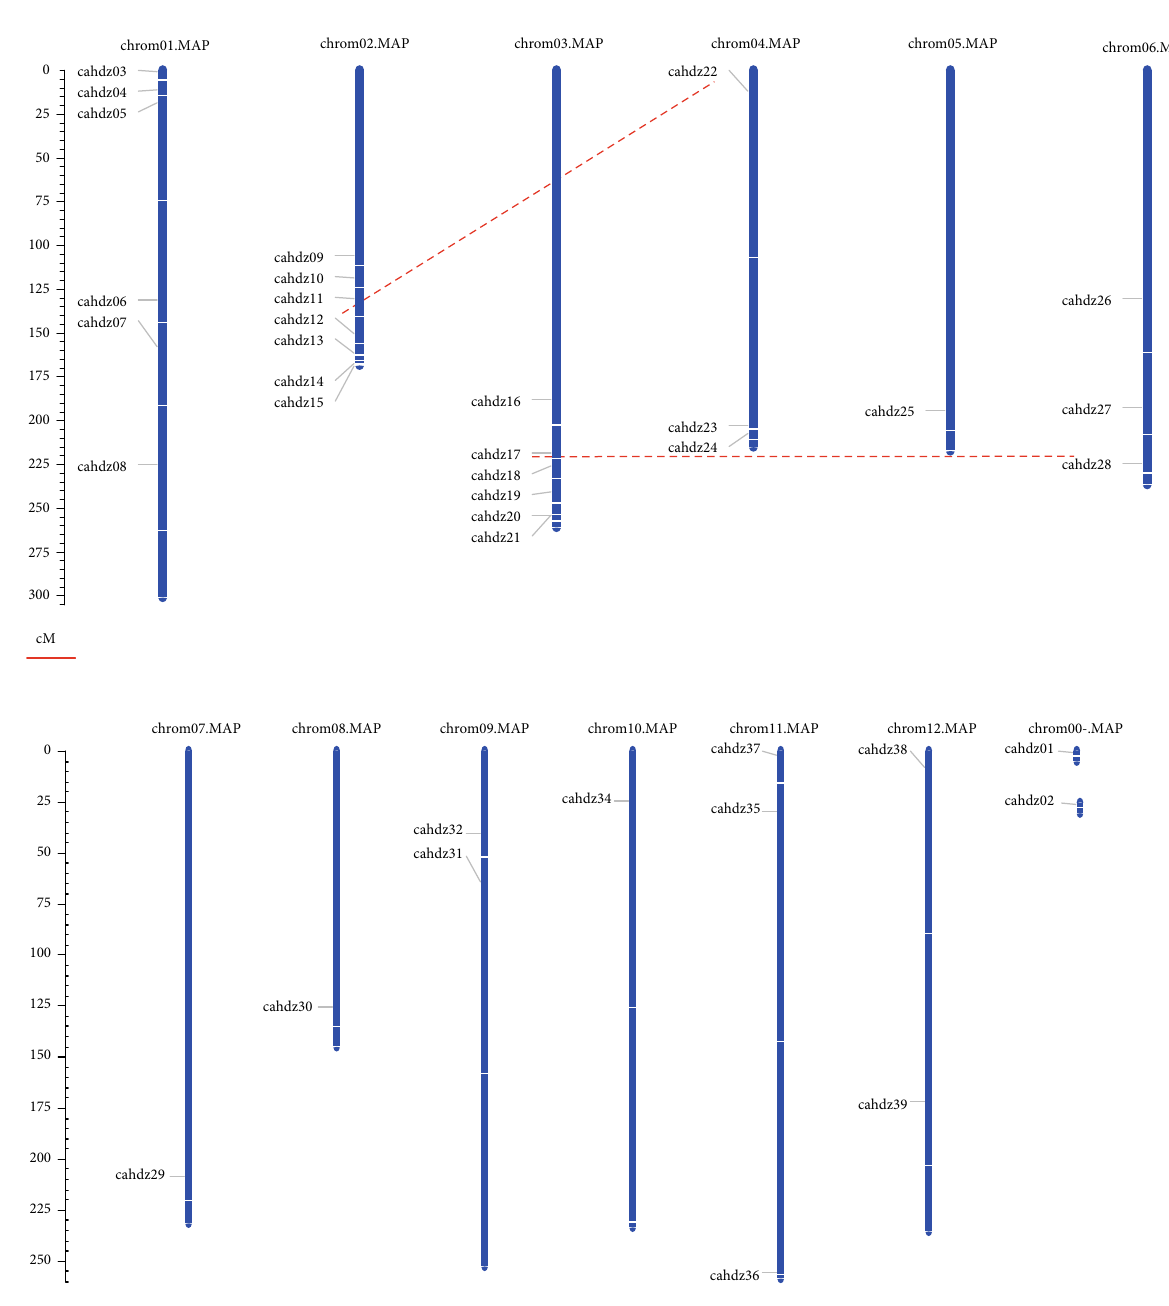
Figure 2: Chromosomal locations and duplication events of CaHD-ZIP genes of pepper. Locations of CaHD-ZIP were based on physical locations. The numbers on the top represent the chromosome number. The chromosome 00 (Chr00) means two di ff erent sca ff olds containing unassigned CaHD-ZIP to any of the 12 pepper chromosomes. Red lines indicate 2 pairs of paralogism genome duplication